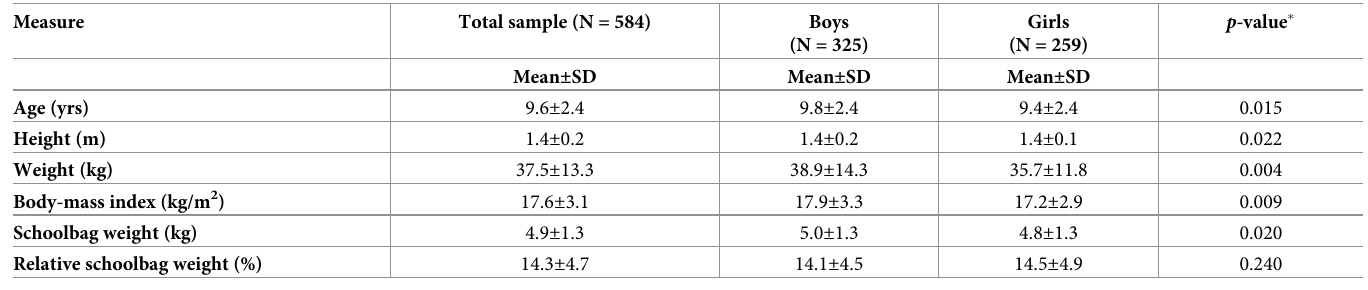
Table 1. Basic descriptive statistics of the study participants, Czech